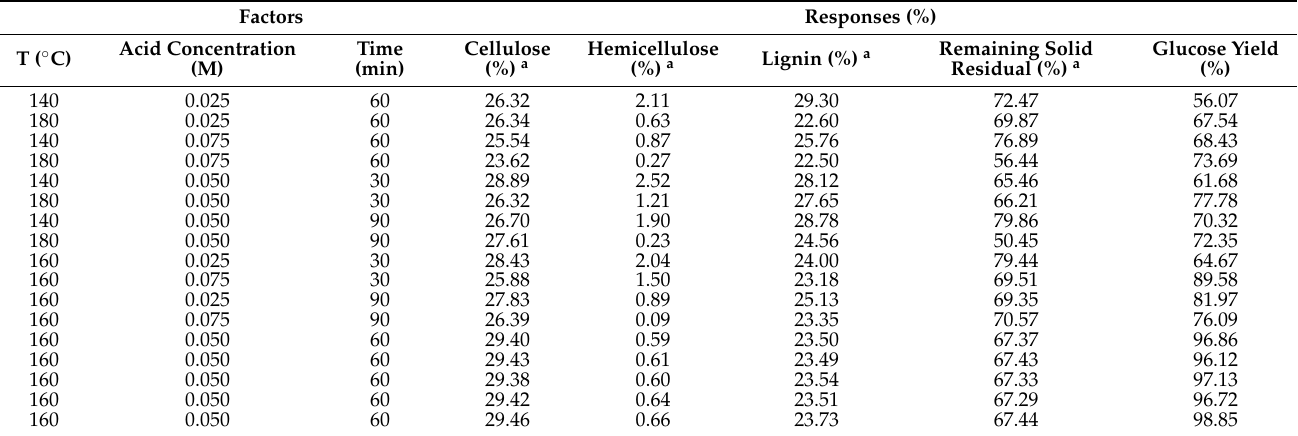
Table 1. The effect of all response surface method in remaining solid residual were analyzed using the Box − Behnken